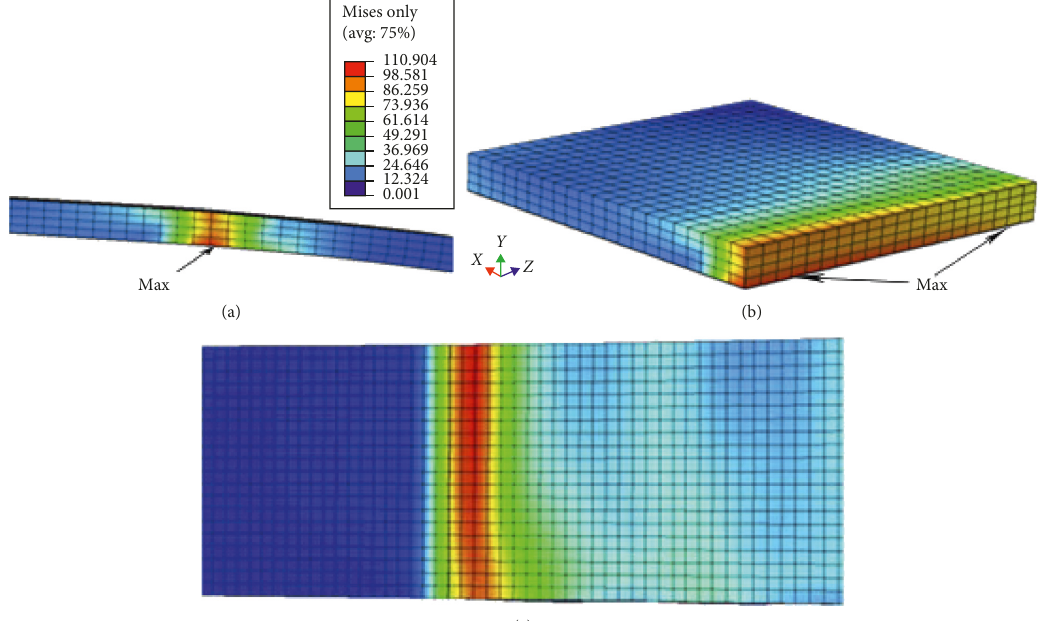
Figure 7: The distribution of equivalent stresses in the thermodeformation hearth (a, b) and in the zone of contact of the tape with the surface of the part (c) in the case of electrocontact surfacing with steel tape at K v � 1.015 and the duration of the current pulse t imp � 0.04sec.